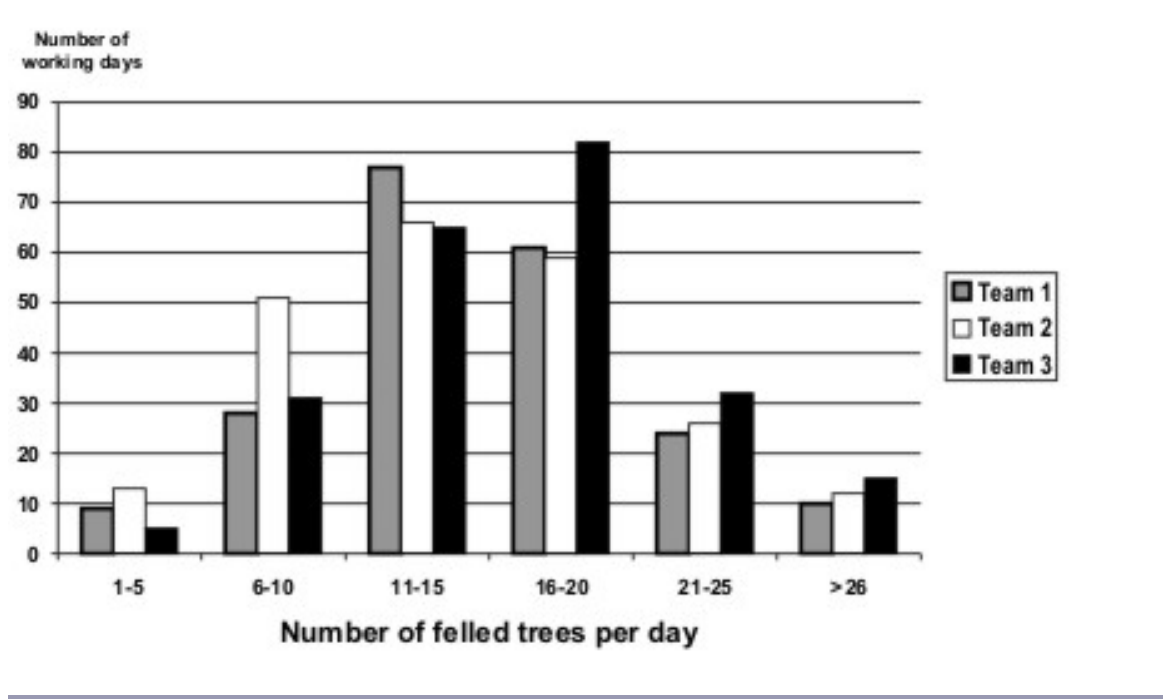
Fig. 4 . Daily productivity of three felling teams during the harvest periods 2000 and 2001, by productivity